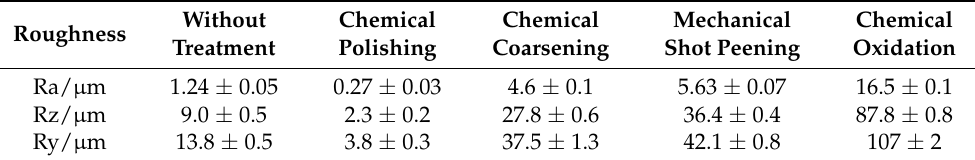
Table 1. Surface roughness of heat sink surfaces with different treatments.